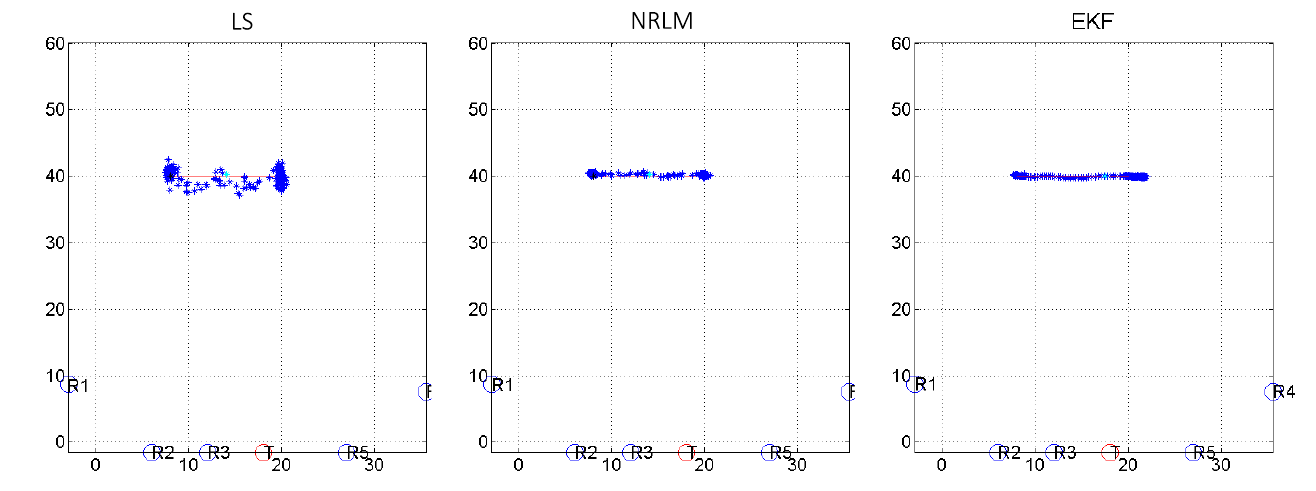
Figure 12. Case 3-1: Target moves from (8, 40) to (20, 40), the velocity in the x -direction is about 1 cm/s. (Blue dots: the estimated coordinates of moving target; red line: the reference target trajectory.)